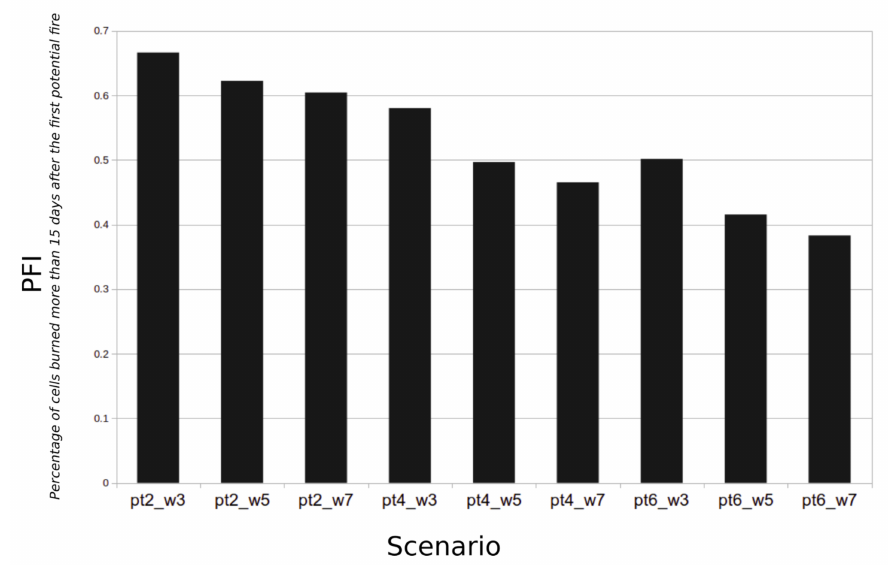
Figure 8. Scenarios according to the percentage of potential fire impact (PFI) (15